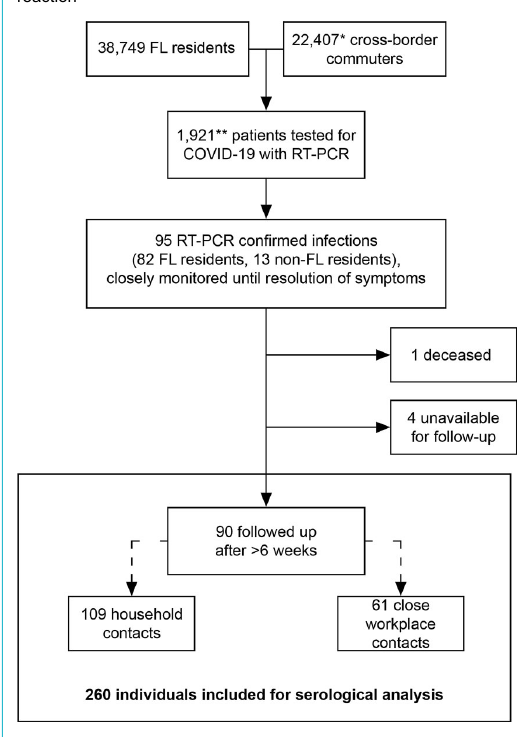
Figure 2: Flowchart of participant inclusion.* Estimated from the headcount of the workforce residing outside Liechtenstein as per 31 December 2018, corrected for overall workforce growth of 2.6% as per 31 December 2019. Data from the National Office of Statis- tics Liechtenstein, Vaduz [13, 14].** As per 23 April 2020 [33]FL = Fürstentum Liechtenstein, RT-PCR = real-time polymerase